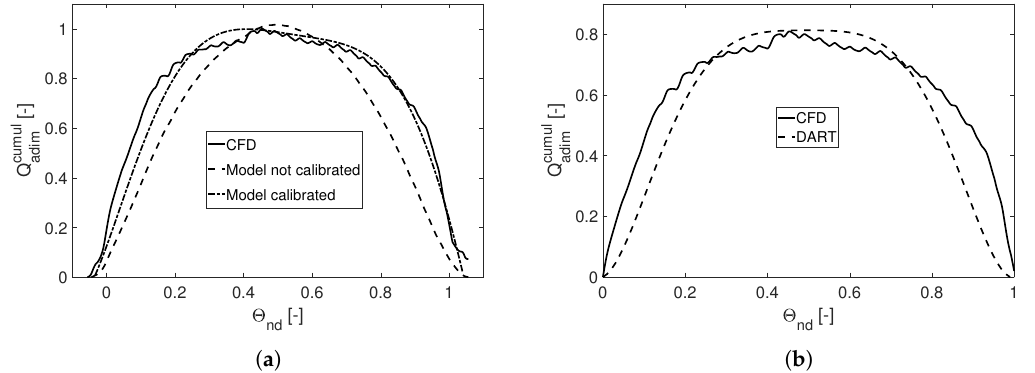
Figure 8. Q cumul comparisons for h / H = 0.00886: ( a ) model and CFD data; and ( b ) DART and CFD